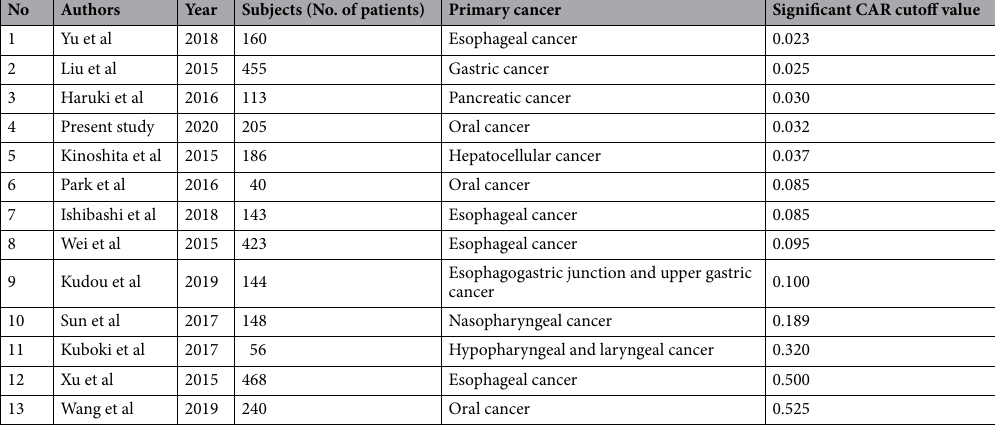
Table 5. Studies evaluating the cutoff value of CAR in various